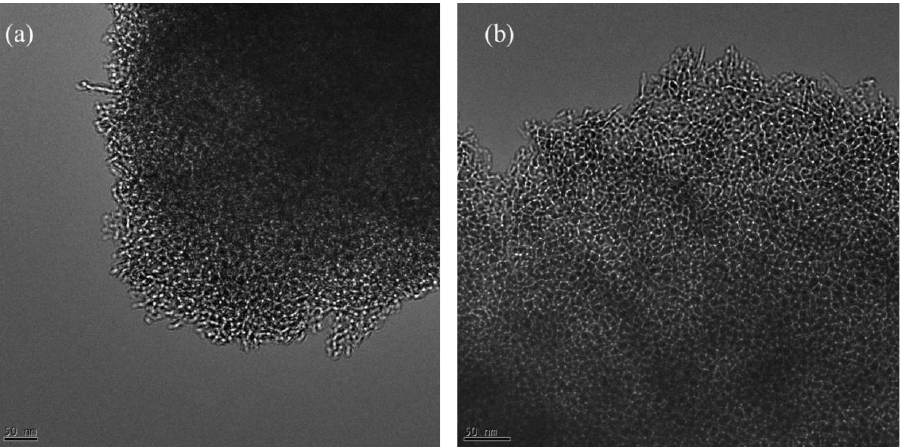
Figure 3. TEM images of Al-Fe 5 -3 ( a ), and Al-Fe 10 -3 ( b ) indicating the presence of disordered but quite uniform mesopores. To discover the composition of the obtained materials, an X-ray fluorescence analysis was carried out. The XRF spectra of the samples studied in comparison to the spectrum of pristine Al 2 O 3 are shown in Figure 4.